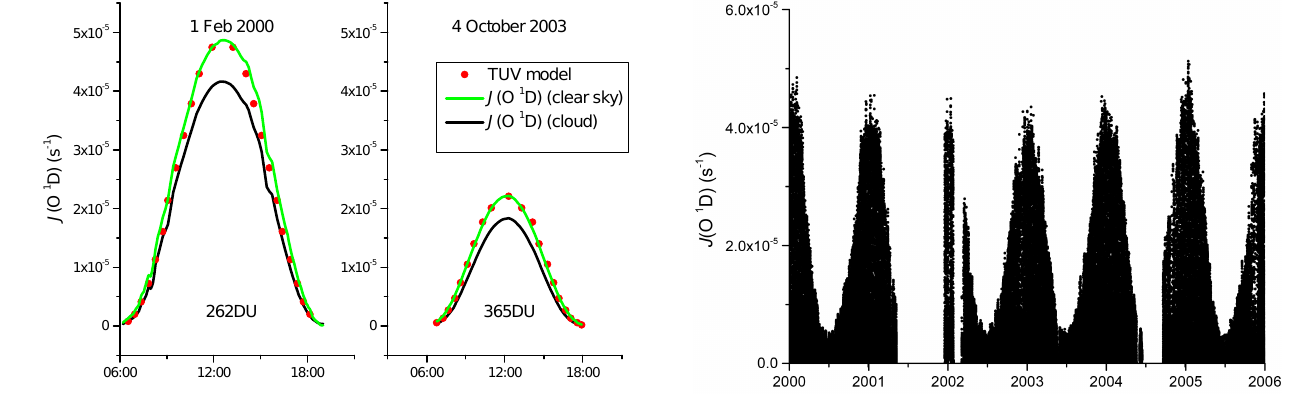
Figure 1. Comparison of clear-sky calculation values to measure- ments. Calculations have been performed with the column ozone amount reported by the TOMS satellite. J (O 1 D) has been calcu- lated using an α of 2.0 relevant to clear skies (green line) and 1.73 (cloudy – black line).